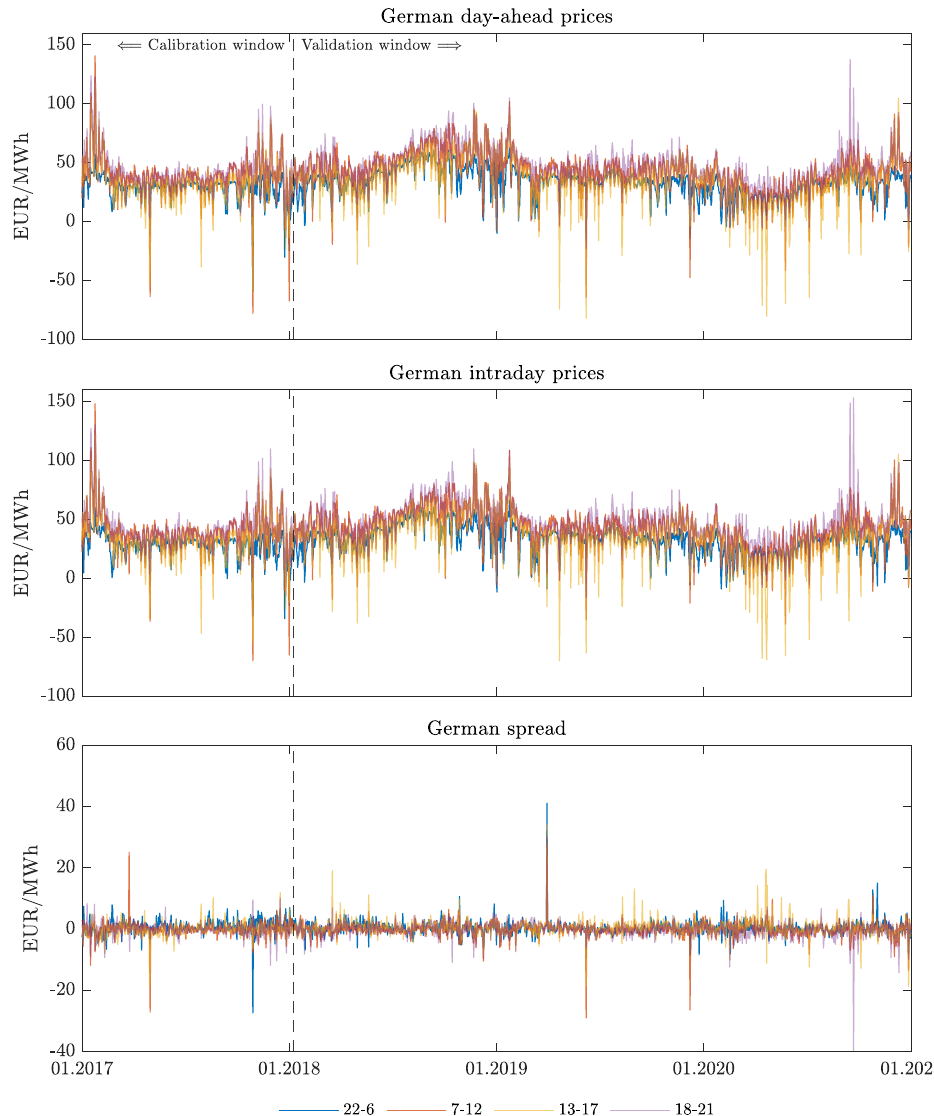
Figure 1. German day-ahead prices ( top panel), intraday prices ( middle panel) and the spread, i.e., the difference between day-ahead and intraday prices ( bottom panel). For illustration the hourly prices were averaged over four representatives blocks of hours: 22–6 (night), 7–12 (morning peak), 13–17 (midday), 18–21 (evening peak). Source: Authors’